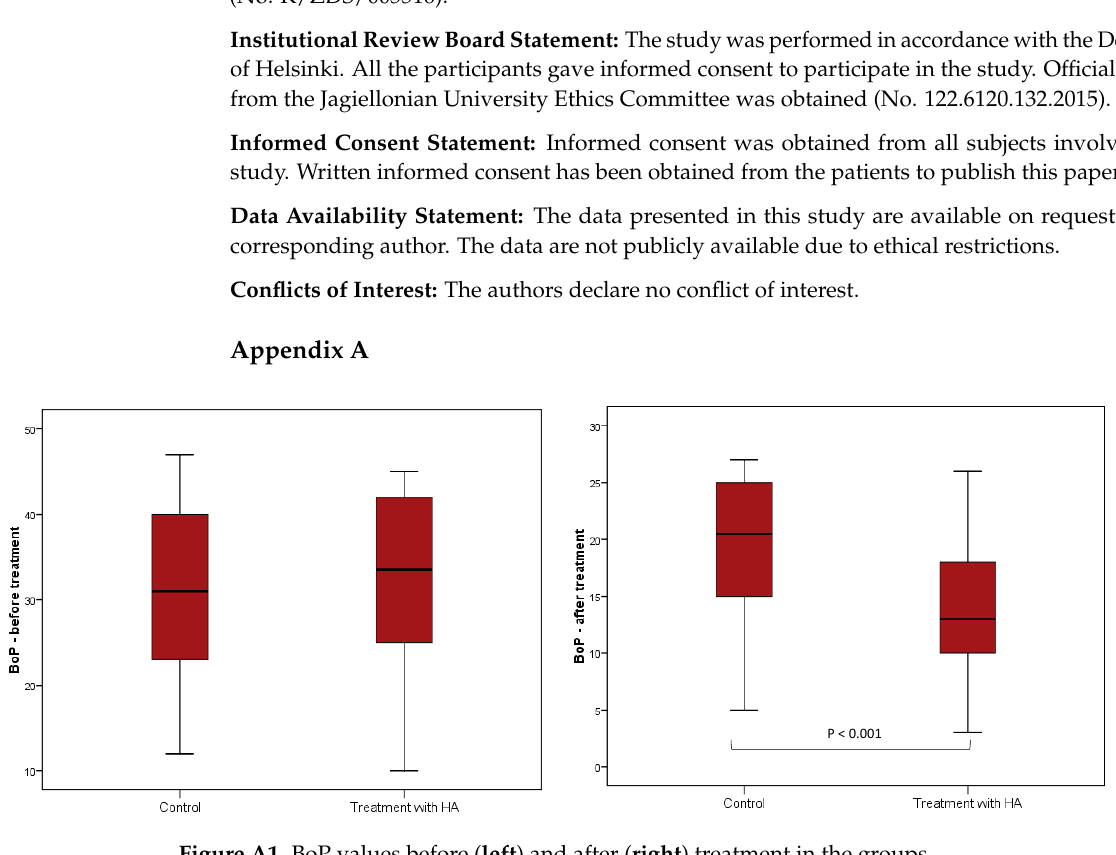
Figure A1. BoP values before ( left ) and after ( right ) treatment in the groups.